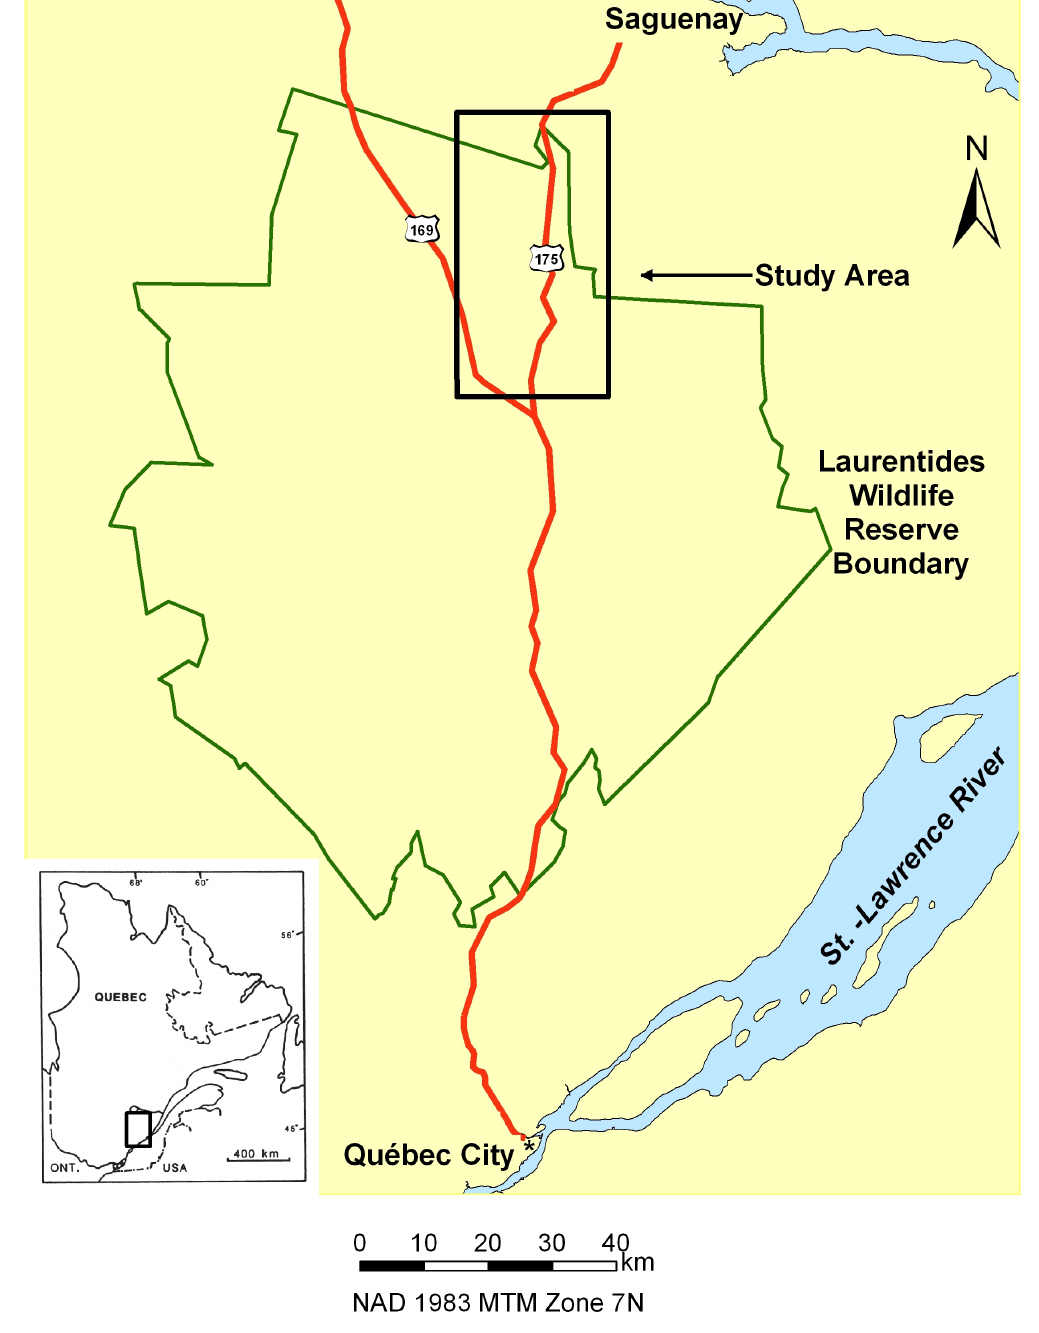
Fig. 3 . The study area is the narrow black rectangle centered on the upper portion of Route 175 above the junction with Route 169. The boundary of the Laurentides Wildlife Reserve (LWR) is outlined in green. The LWR is situated between Quebec City and Chicoutimi in the Province of